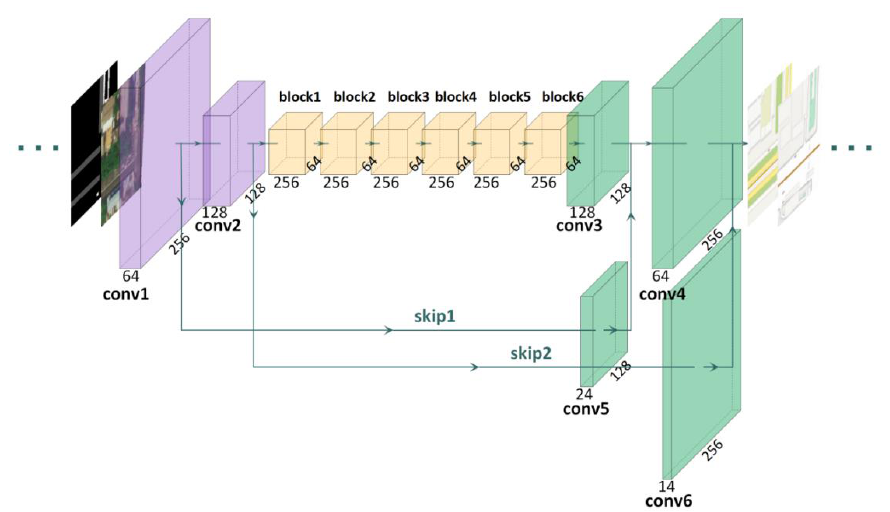
Figure 4. The generator architecture of MapGAN.